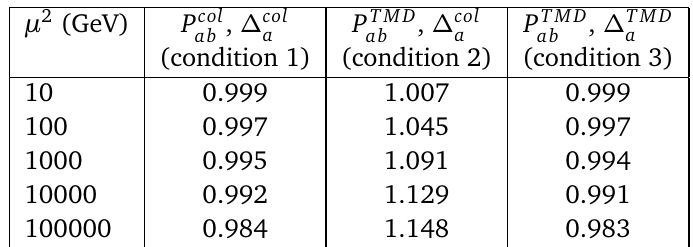
(cid:82) 1 ( x , µ 2 ) d x ˜ f a 10 − 5